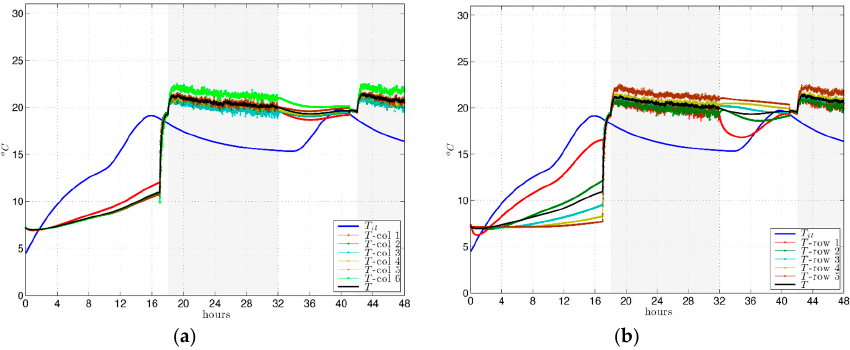
Figure 11. Case 2: Efficient energy proposal. Winter. Internal layer temperature T il and averaged room temperature T together with calculated indoor temperatures at the probe points given in Figure 4. ( a ) by columns; ( b ) by